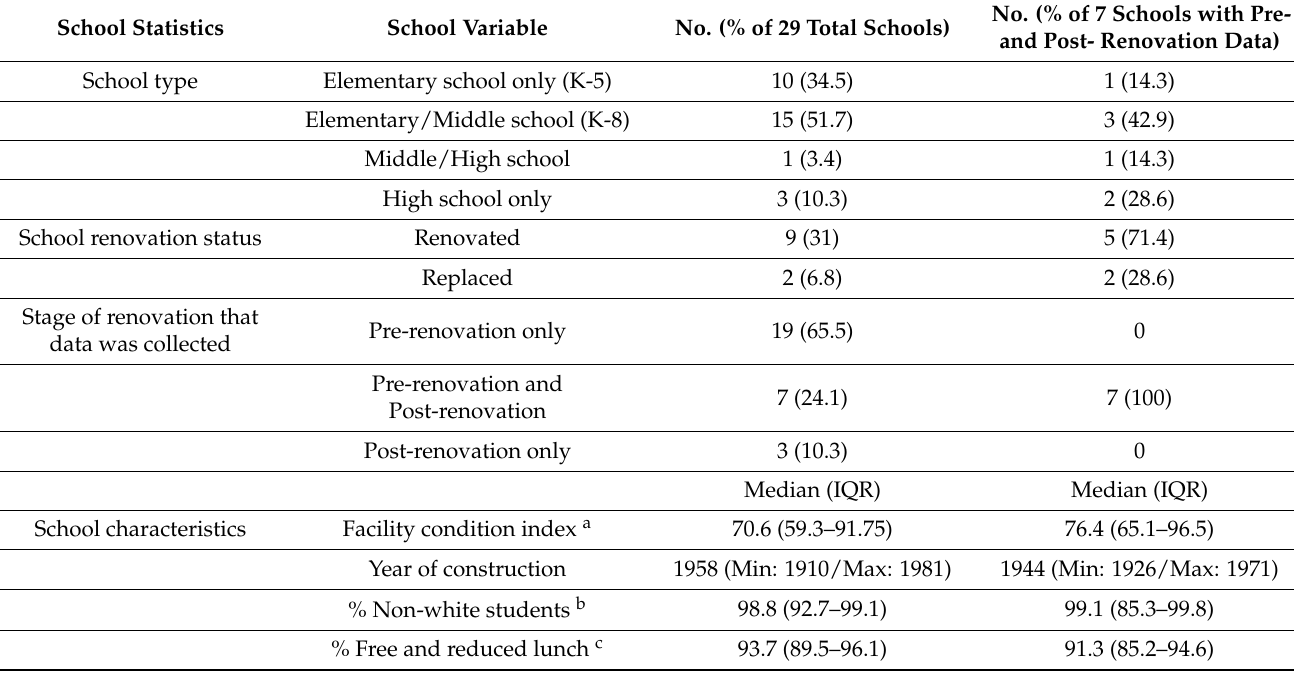
Table 1. Characteristics of